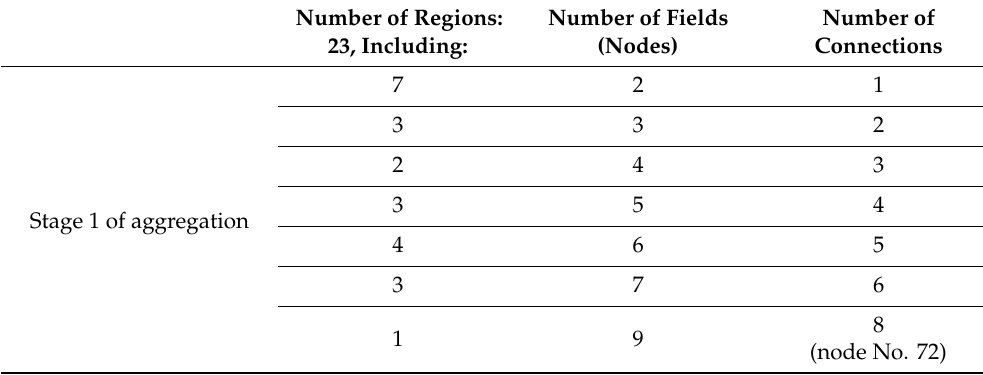
Table 3. Characteristics of the structure of networks formed according to the maximum value difference path. Number of Regions: 23,